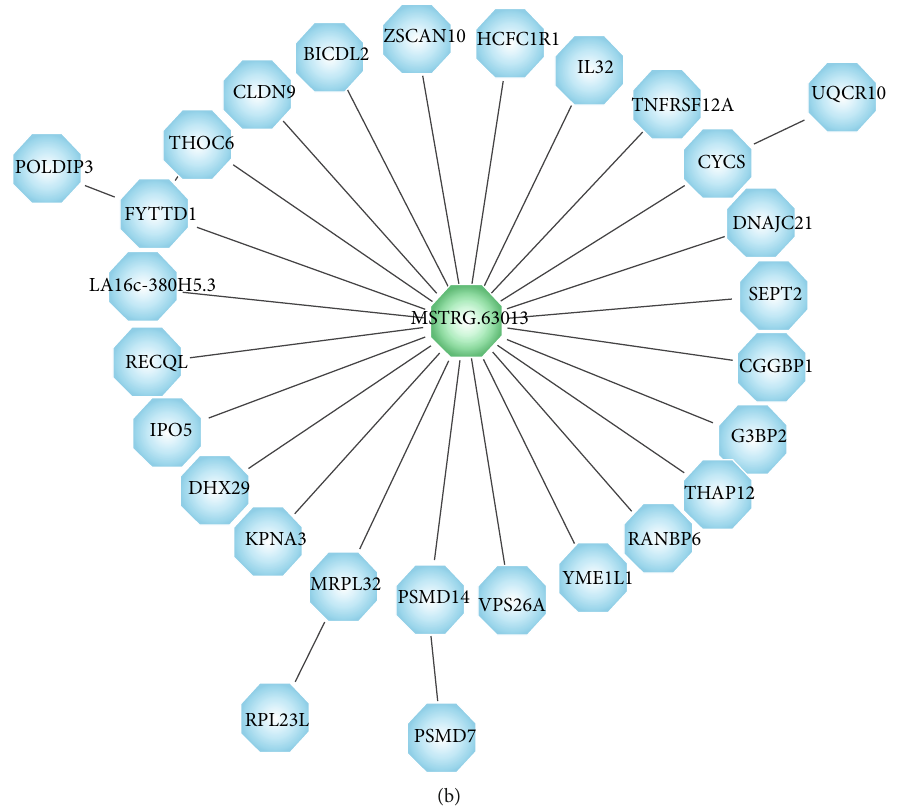
Figure 5: The construction and analysis of a gene coexpression regulation network. (a) Coexpression networks of lncRNA-mRNA derived from 156 network nodes and (b) the network of key lncRNA